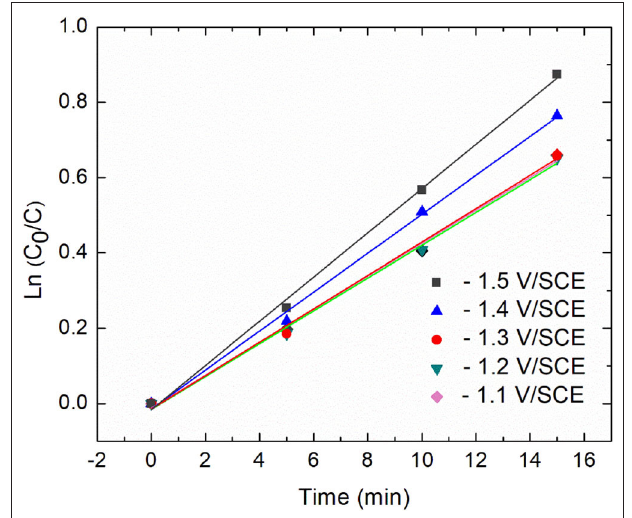
FIGURE 4 | Relationship between diatrizoate removal yield and time during 15min electroreduction for five different applied potentials.